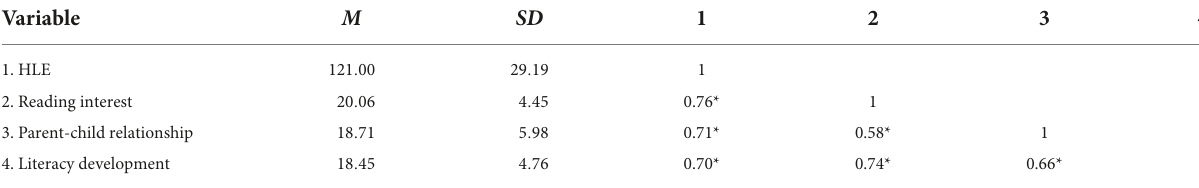
TABLE 2 Correlation analysis results of variables.